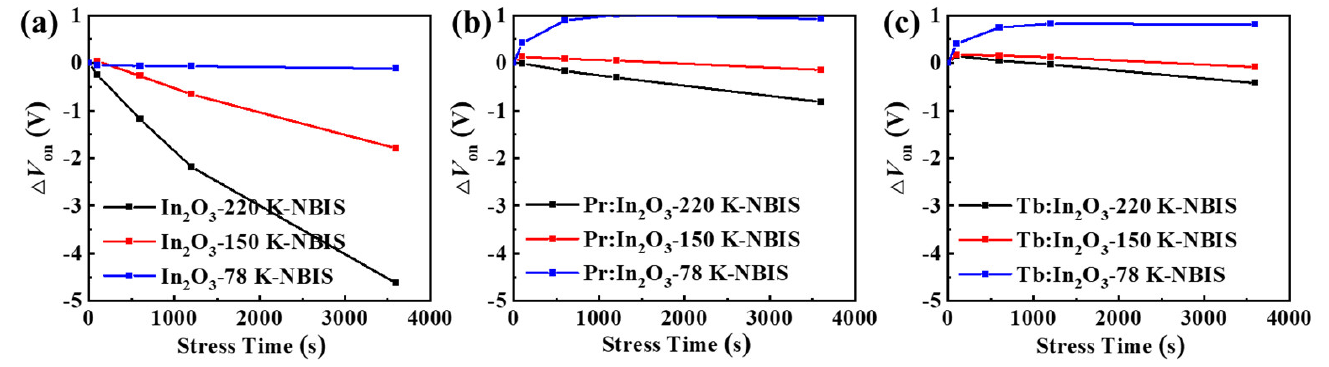
Figure 5. ΔV on evolutions of the TFTs with ( a ) pure In 2 O 3 , ( b ) Pr:In 2 O 3 , and ( c ) Tb:In 2 O 3 under NBIS with different temperatures of 78 K, 150 K, and 220 K.